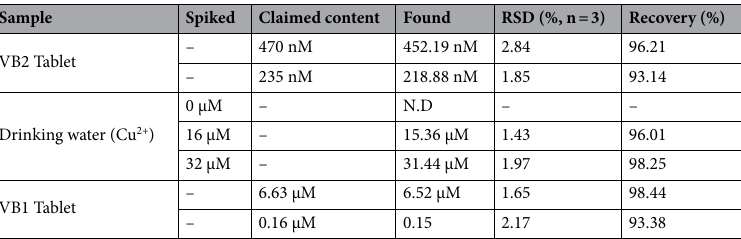
Table 2. Analytical results for the sequential multi component detection of riboflavin, Cu 2+ and thiamine in real samples (n =